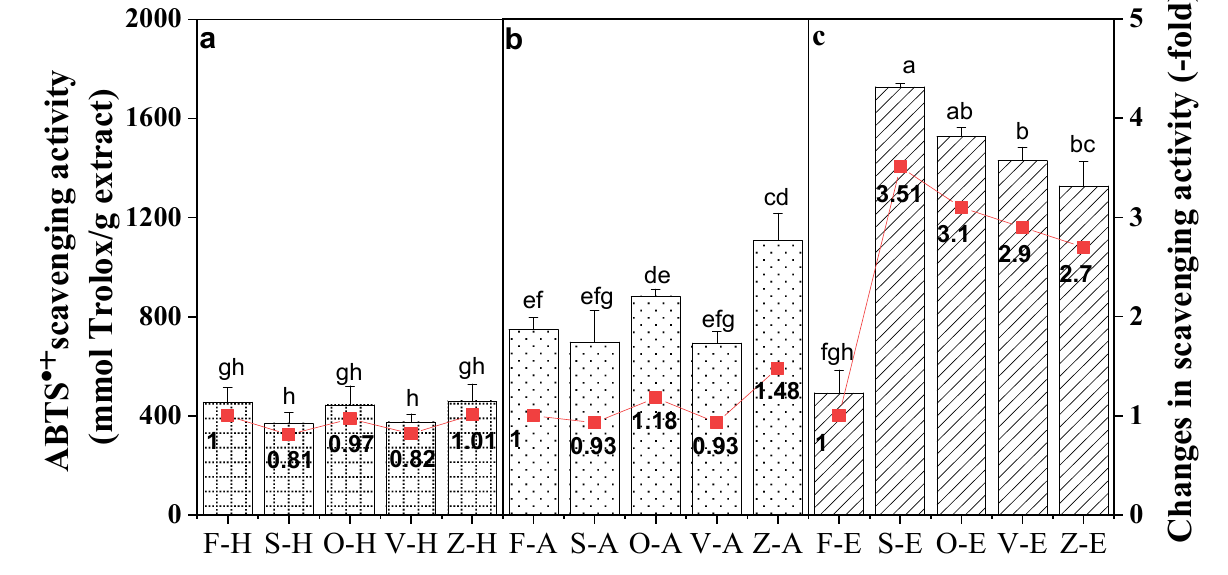
Figure 4. ABTS • + scavenging activity of Bentong ginger extracted using ( a ) hot water (H), ( b ) aqueous (A) and ( c ) ethanol (E) solvents via sun (S)-, oven (O)-, vacuum (V)- and freeze (Z)-drying methods. Fresh ginger (F) was used as the control. Changes were calculated based on the respective fresh ginger samples. Bars with different letters are significantly different. Sample F-H = Fresh ginger (Control) with hot water, and sample Z-E is freeze-drying with